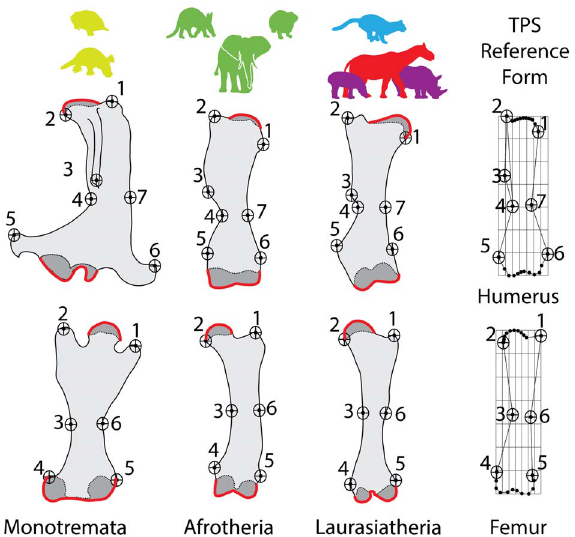
Figure 2. Landmarks digitized for 2-D thin-plate splines (TPS) geometric morphmetric (GM) analyses – Archosaurs. All drawings are not to scale and were enlarged or reduced to facilitate comparisons. For the humerus, landmarks 1 and 2 encompass the region of the humeral head. Landmarks 2, 3, and 4 encompass the extent of the deltopectoral crest. Landmarks 4 and 7 encompass the narrowest point of the midshaft. Landmarks 5 and 6 denote the lateral and medial epicondyles, respectively. For the femur, landmarks 1 and 2 encompass the region of the femoral head. Landmarks 3 and 6 encompass the narrowest point of the midshaft. Landmarks 4 and 5 denote the the lateral and medial epicondyles. Regions of sub-articular bone are indicated in dark gray and the digitized outlines that were subsequently converted into chains of 10 evenly-spaced semi- landmarks are colored red. The exemplar taxa represented as bones, left to right, are: Alligator , Torneria (‘‘ Barosaurus ’’), and Allosaurus . Given that birds were included in the Archosauria sample, the fourth trochanter (4 Tr) was not digitized. The TPS reference forms which describe the shape of the bones mathematically is shown at